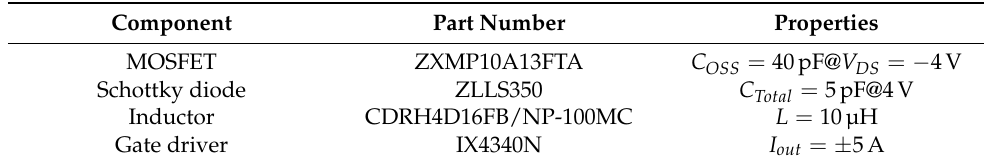
Table 1. Components used in the